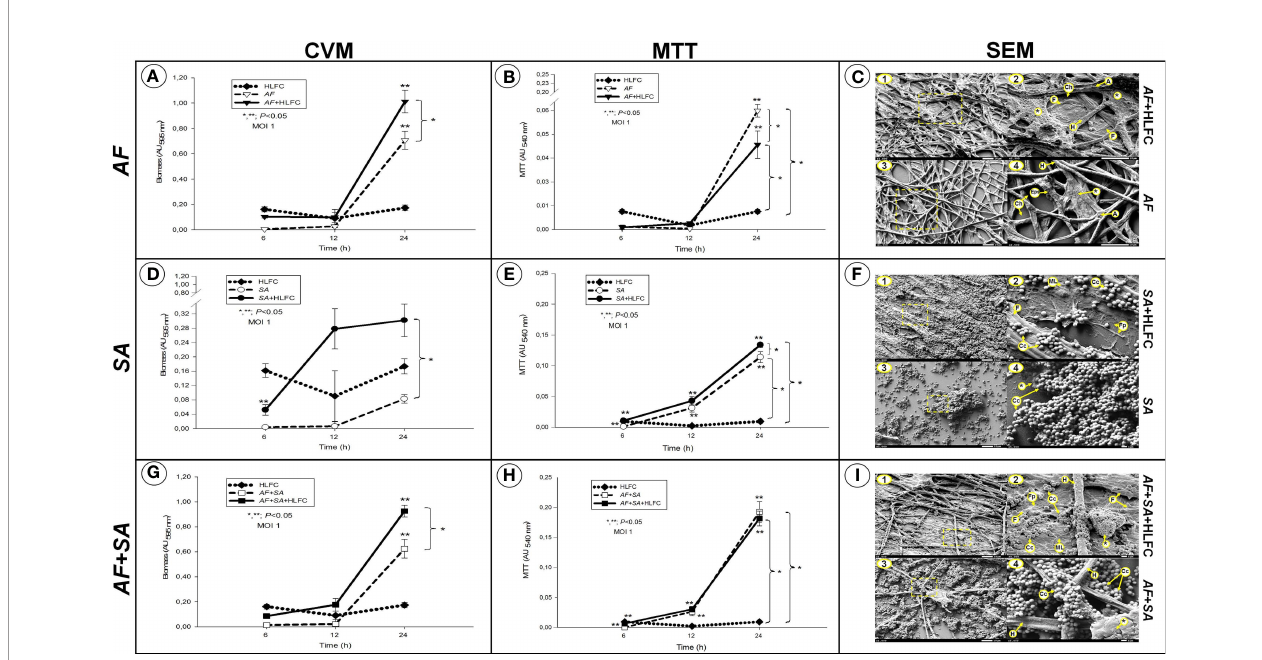
FIGURE 1 | Quanti fi cation of microbial bio fi lms on primary HLFCs. Biomass quanti fi cation using the Christensen crystal violet method (CVM). AF (A) , SA (D) , and the FBI AF+SA (G) with and without HLFCs. Metabolic activity quanti fi cation using the tetrazolium salt reduction method (MTT) on the bio fi lm AF (B) , SA (E) , and AF+SA (H) with and without HLFCs. The results are four replicates of three different experiments: n = 12. Signi fi cance was determined using the Student – Newman – Keuls test with multicomparison of procedures and are indicated as: (*), p < 0.050. SEM micrographs of bio fi lms of AF+HLFC ( C1 : 1,000×, C2 : 2,500×) and AF ( C3 : 1,000×, C4 : 2,500×); bio fi lm of SA+HLFC ( F1 : 1,000×, F2 : 5,000×) and SA ( F3 : 1,000×, F4 : 5,000×); and bio fi lm of AF+SA+HLFC ( I1 : 1,000×, I2 : 5,000×) and AF+SA ( I3 : 1,000×, I4 : 5,000×). HLFCs, human limbo-corneal fi broblast cells; AF, Aspergillus fumigatus ; SA, Staphylococcus aureus ; H, hypha; F, fi broblast; A, anastomosis; Ch, channels; Asterisk (*), extracellular matrix; Eps, exopolymeric substance; ML, monolayer; Fp, fi lopodia; Cc,